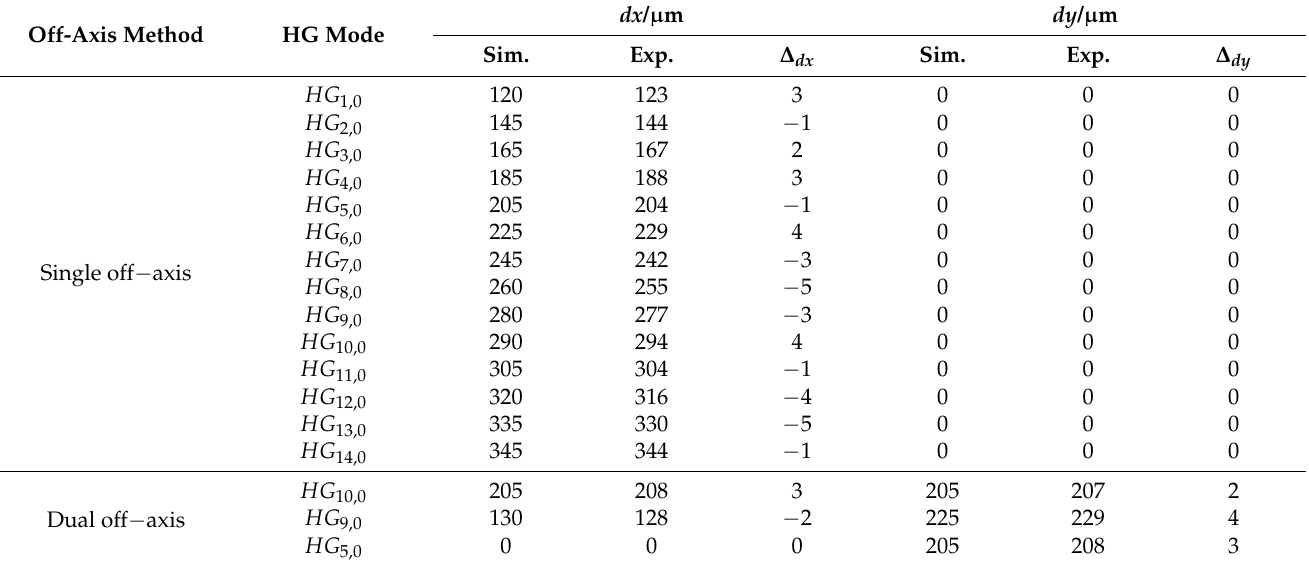
Figure 14. The generated HG and vortex beams in the single off-axis displacement experiment. Table 3. The comparison of the off-axis displacements ( dx , dy ) in the simulation and